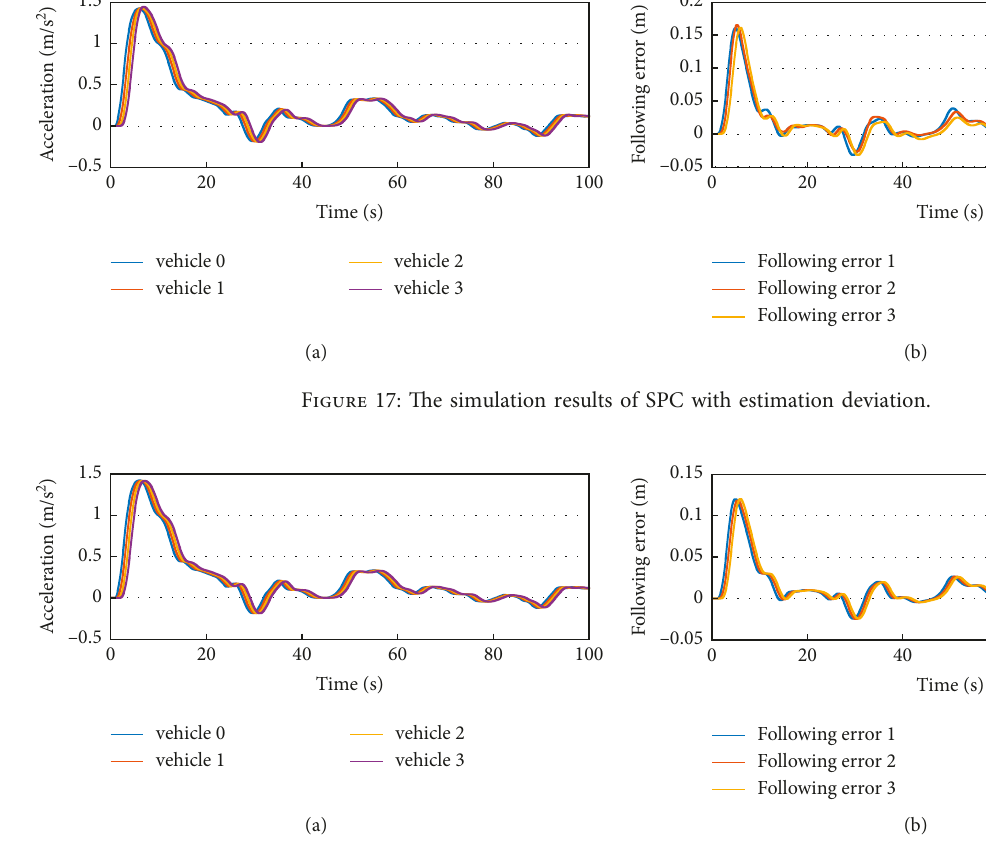
Figure 18: The simulation results of DOB-SPC with estimation deviation.